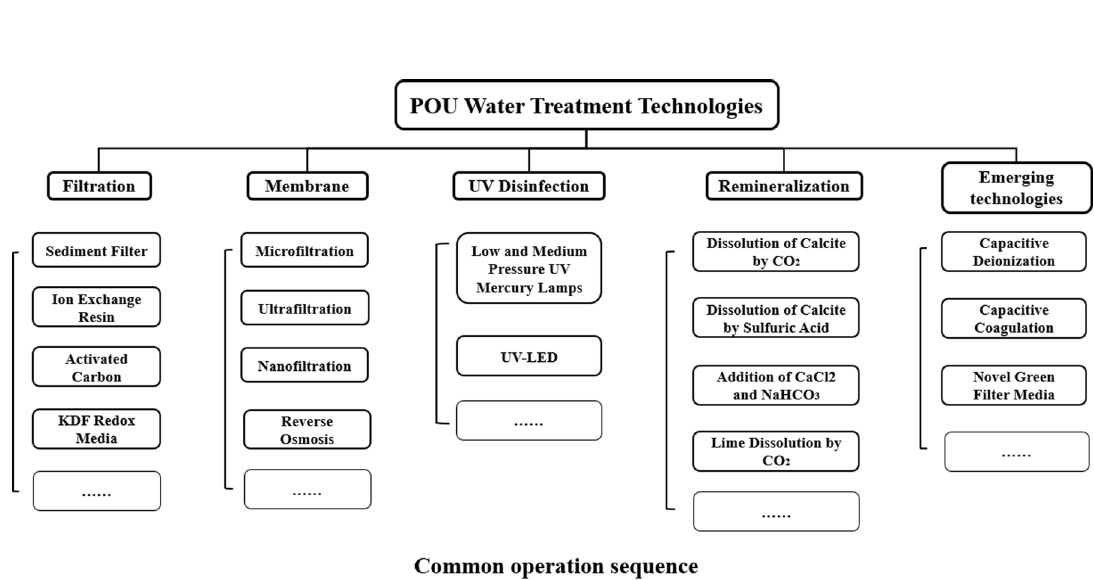
Fig. 4 Examples of POU water treatment technology sequences. A wide range of point-of-use technologies have emerged in the past two decades including activated carbon, redox media, RO membranes, UV disinfection, CDI, and others.